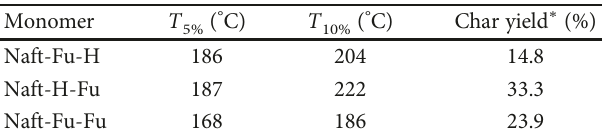
∗ Measured as the residual mass at 800 °